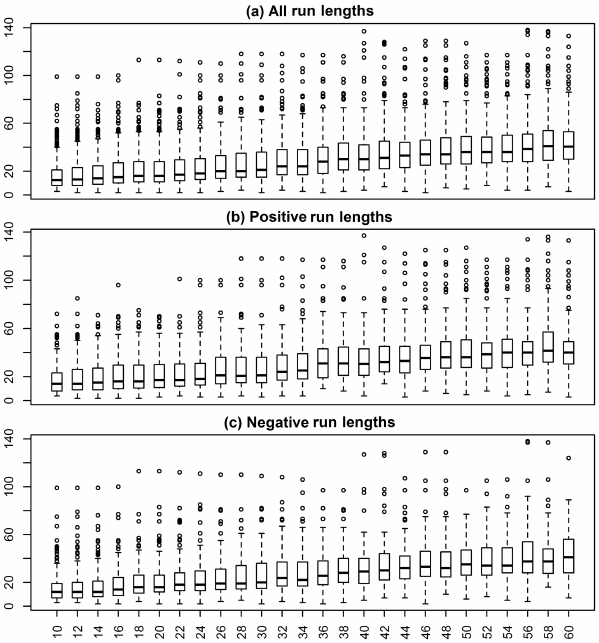
Figure 4. Box plot of run length samples from all reconstructions with different window widths in the Mann–Whitney